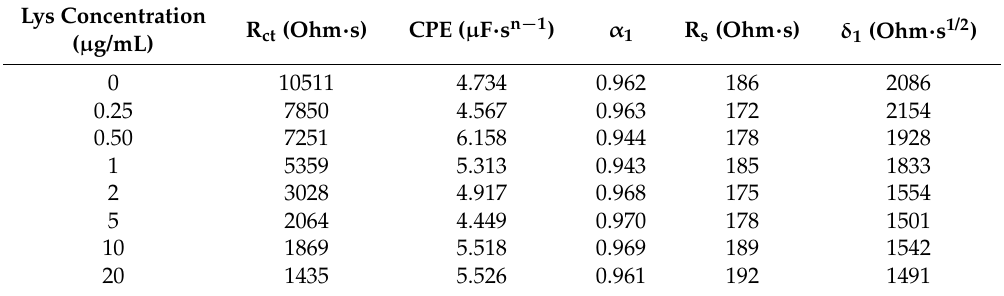
Table 1. Randles circuit parameters for the post-lysozyme Nyquist curves in Figure 8i. Data extracted using Zfit program of Bio-Logic EC-Lab software.